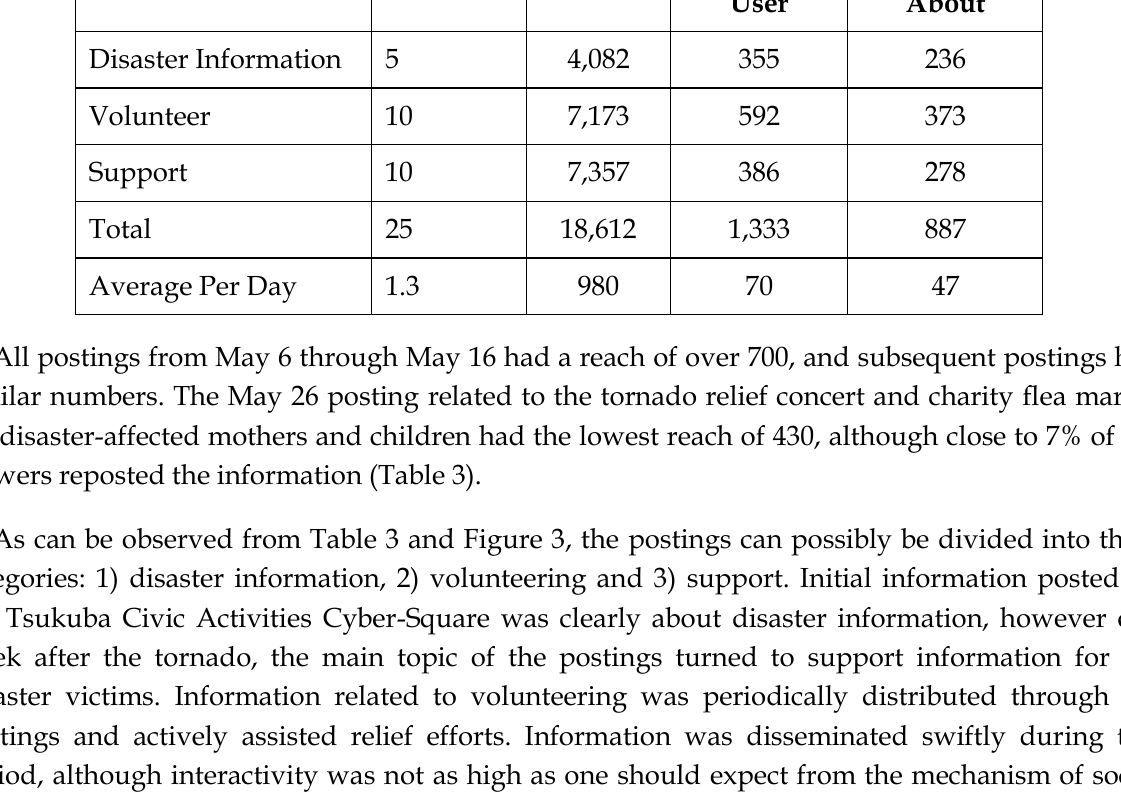
Table 4: Category, Postings, Reach, Action, Talking about – Tsukuba Tornado May 6 to 26, 2012 Category